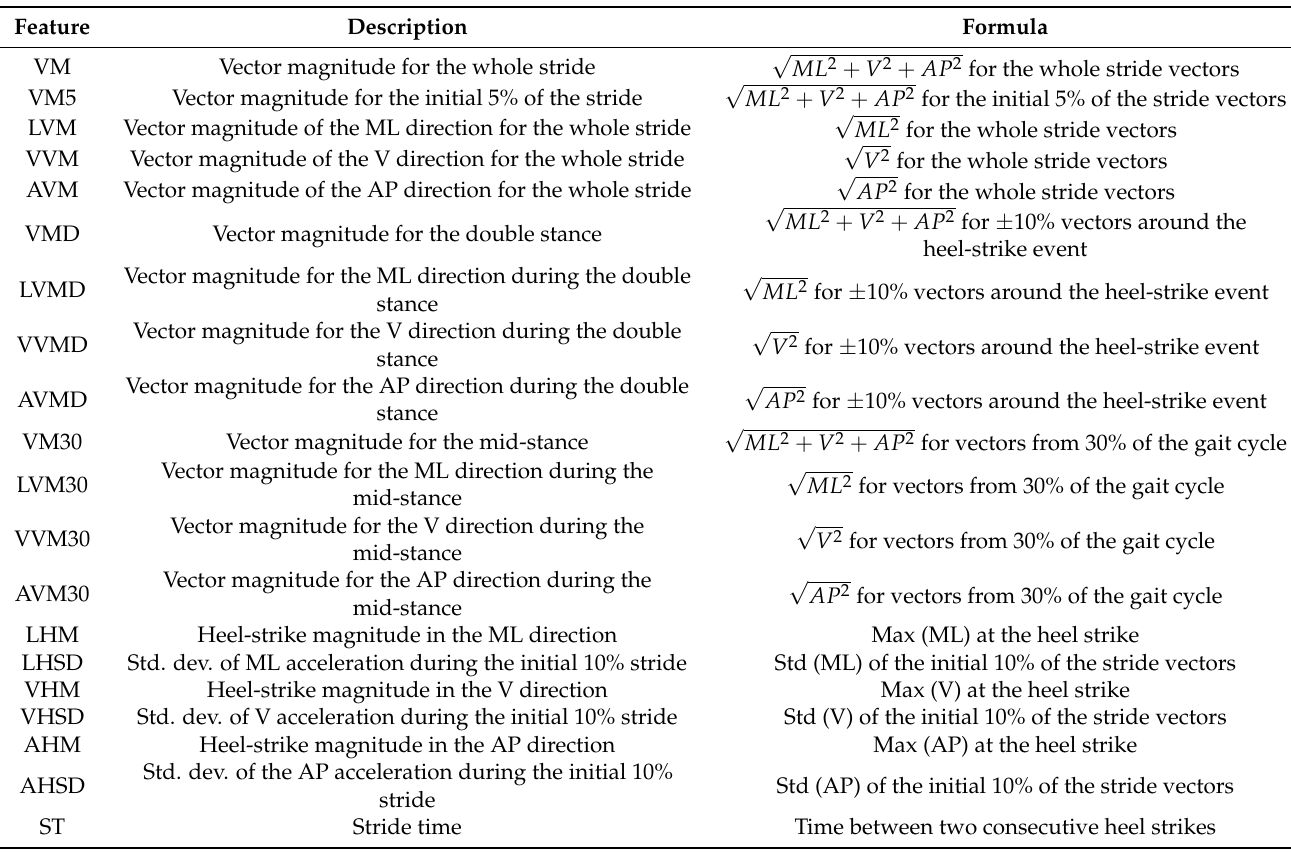
Table 2. Description of features